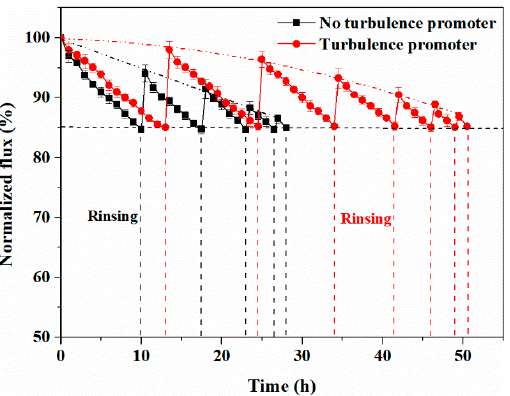
14 of 18 Figure 13. Variations of normalized flux with time (SSTS: 500 ppm HA, pH = 4; TMP = 0.5 MPa). 4.3.2. Experiment with HA Concentration at 250 ppm Figure 14 shows the variation of the normalized flux with time in the SSTS (250 ppm HA, pH = 4). As illustrated in Figure 13, for the case without the turbulence promoter, the cyclic filtration experiment contained five cycles and the FRR could not reach 85% after 28 h of the experiment, indicating that the membrane life was 28 h. For the case with the turbulence promoter, the cyclic filtration experiment lasted for seven cycles and the FRR could not reach 85% after 50.5 h, indicating that the membrane life was 50.5 h. Hence, for the experiment with HA concentration at 250 ppm, the turbulence promoter increased the membrane life by 80.4%. The fitting equations of the FRR with time under the condition of not adding the turbulence promoter and adding the turbulence promoter are Equations